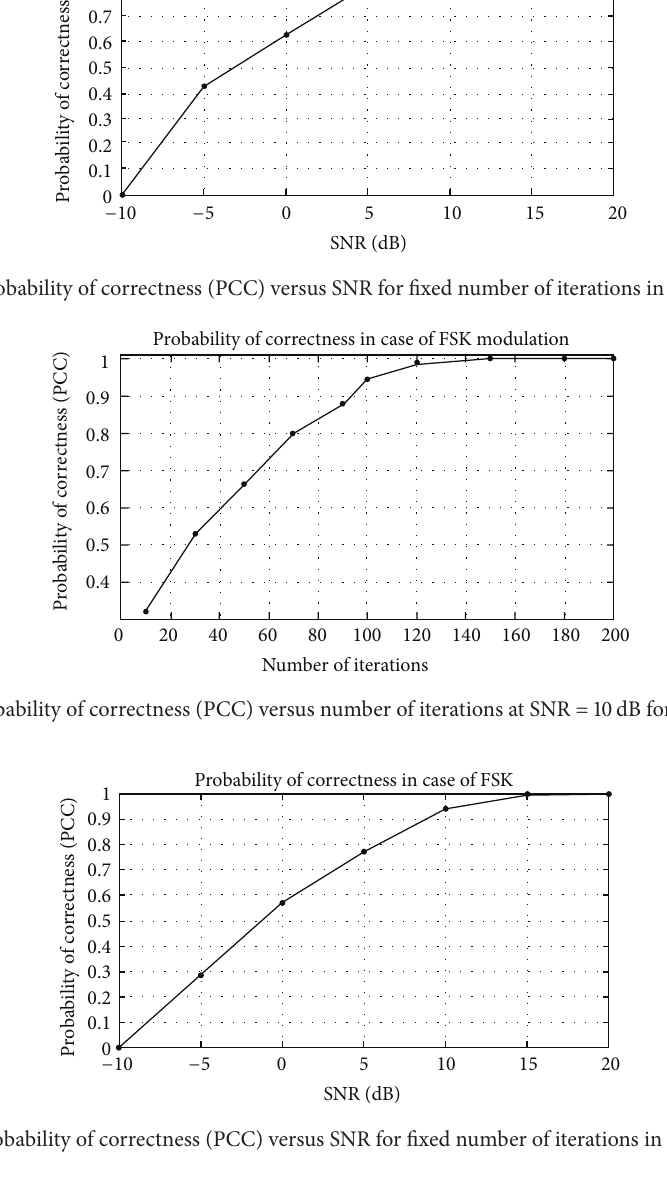
200. The FSK 16 example is classified accurately among the group of considered modulation